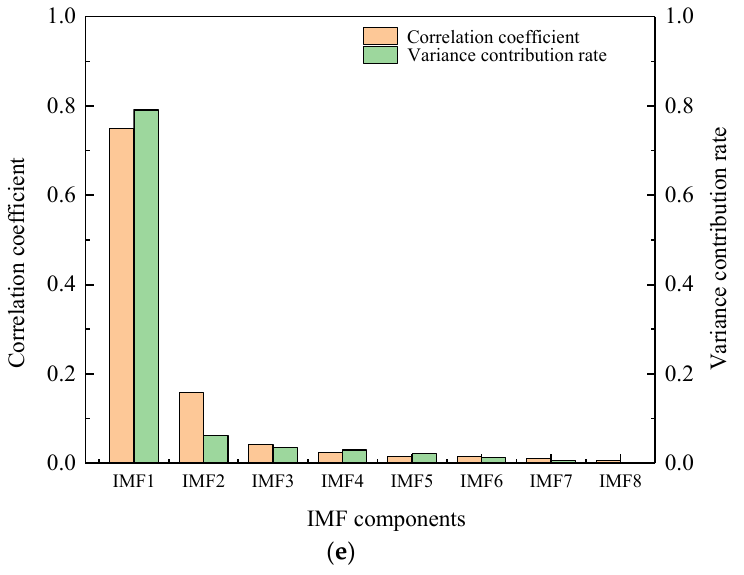
Figure 3. Component correlation coefficient and variance contribution rate under the decomposition of five algorithms of rolling bearing: ( a ) EMD, ( b ) CEEMD, ( c ) VMD, ( d ) EWT, and ( e ) CEEMDAN. Table 2. Comparison of noise reduction effect of simulated bearing.